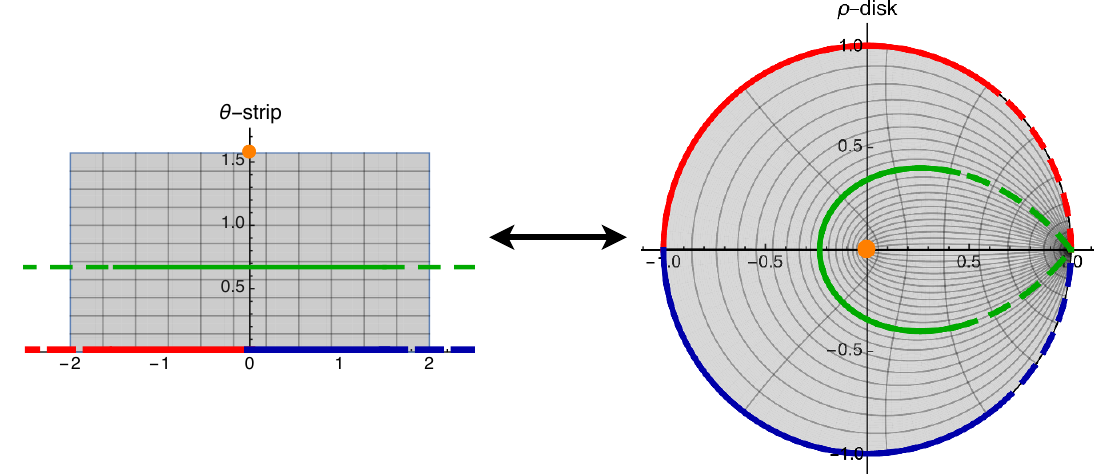
Figure 4 . Illustration of the conformal map in eq. (4.1) with (cid:12) = i(cid:25)